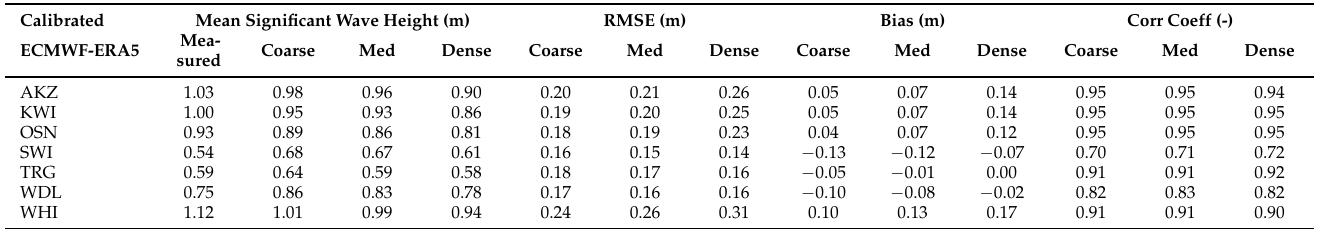
Table 11. Calibrated SWAN model forced by the ECMWF-ERA5 wind database showing the mean wave heights, RMSE, Bias and correlation coefficient relative to measured data at Belgian coastal measuring